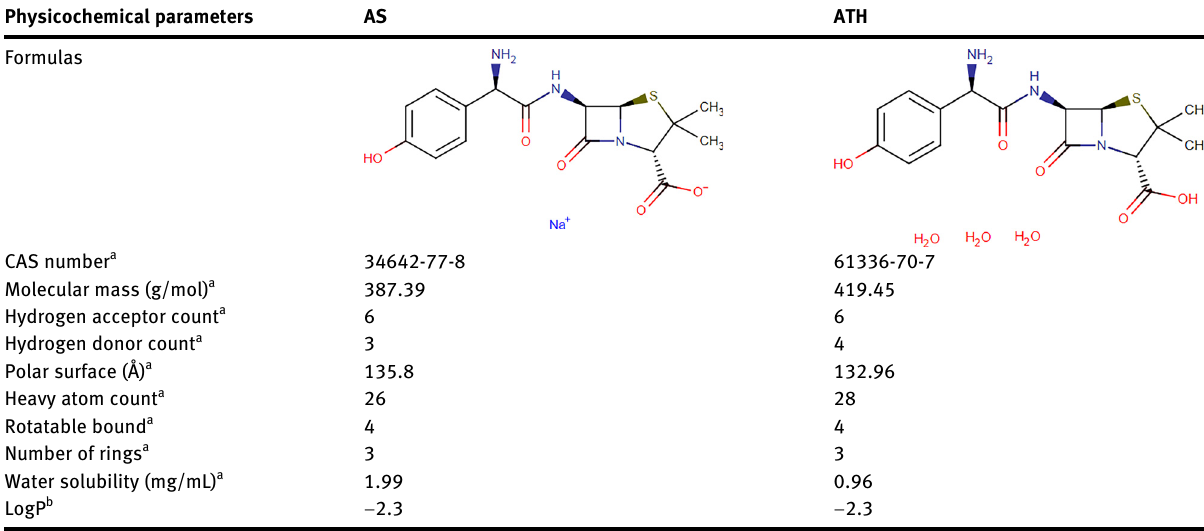
Table  : Molecular descriptors and physicochemical properties of AS and ATH. Physicochemical